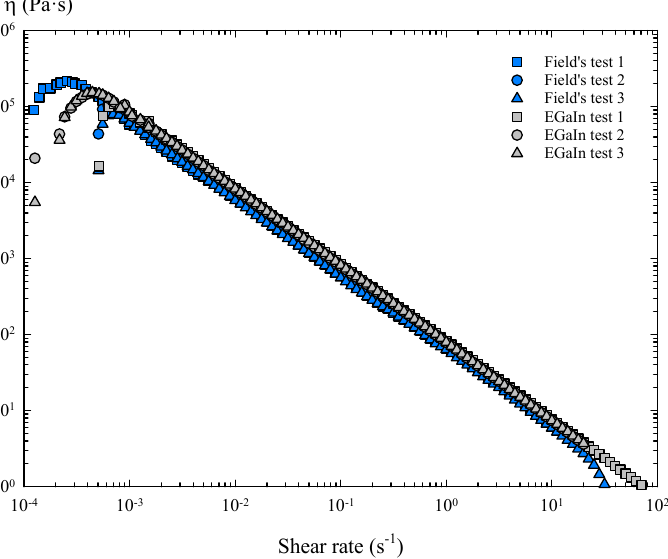
shear thinning behaviour and slightly lower viscosity values than the oxidized EGaIn over a wide range of shear rates (Figure 8).